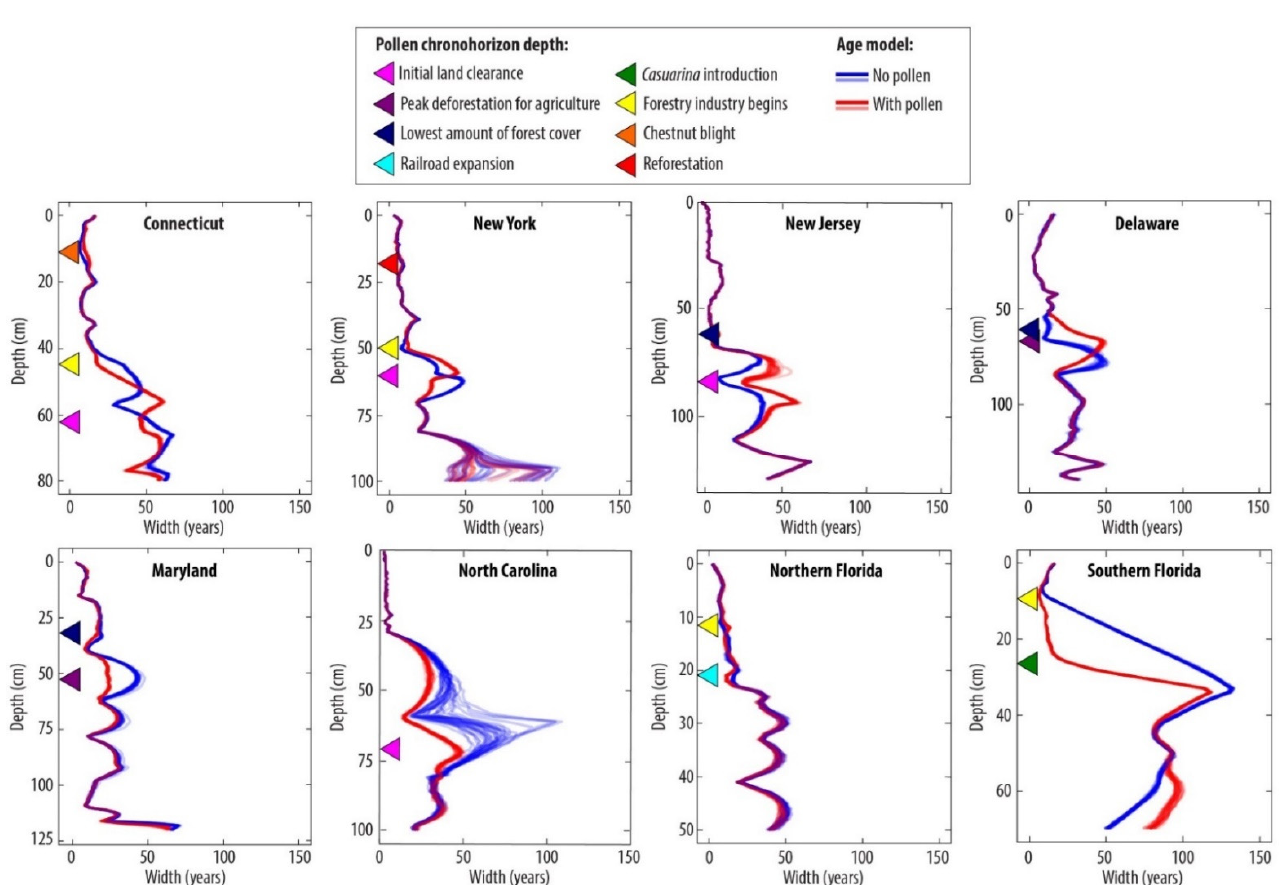
Figure 5. Comparison of the difference in width of the 50% UI between the WP (all chronohorizon in red) and NP (blue) models over the interval from 1500 CE through the present (see also Figure A2). The red and blue lines are plotted transparently so that lighter areas represent widths that are predicted less frequently by Bchron, while darker areas represent widths that are predicted more frequently. The depth of the pollen chronohorizons is plotted using colored triangles which correspond to Figure 3. Table 4. Comparison of with pollen (WP) and no pollen (NP) age–depth models. Positive numbers in the columns titled “Average change of 50% UI width” represent a decrease in precision (widening) and negative numbers represent an in- crease in precision (narrowing). Average changes of <5 years are considered not to have changed. In the column titled “Average change in location of median”, positive numbers indicate that the addition of pollen caused the model to predict younger ages, while negative numbers indicate that including pollen caused the model to predict older ages for sediments in the depth range listed.